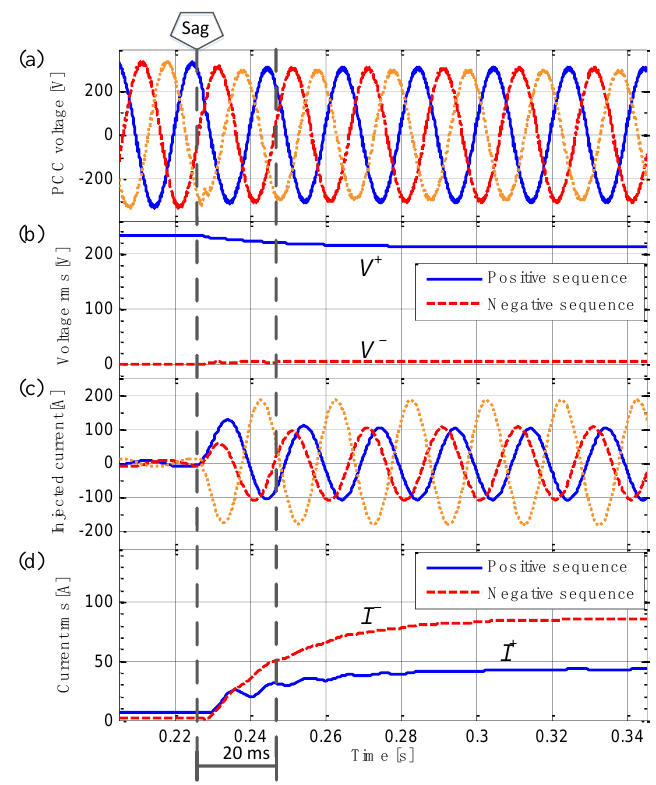
Figure 15. Single SPC-based power converter working. Transient response after the start of an unbalanced sag: ( a ) voltage at the PCC; ( b ) positive- and negative-sequence voltage rms; ( c ) current injected by the converter; and ( d ) positive- and negative-sequence current rms.